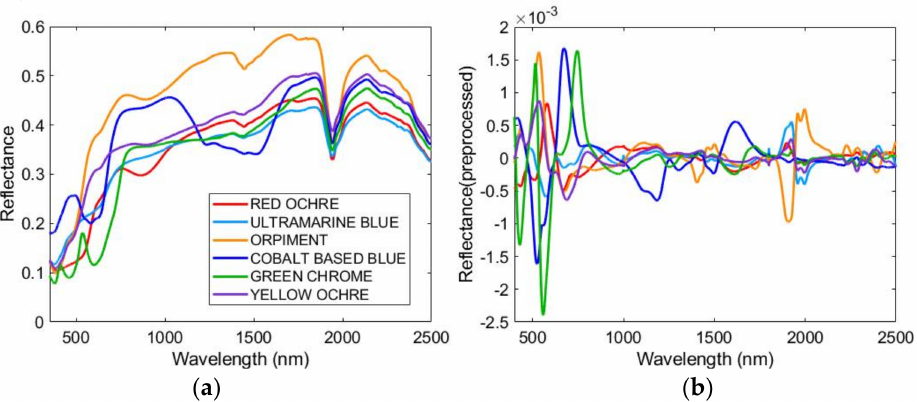
Figure 4. Raw reflectance spectra ( a ) preprocessed spectra ( b ) obtained by detrend (2nd order), 1st derivative (order, 2; window, 55 pt; tails, weighted), and mean